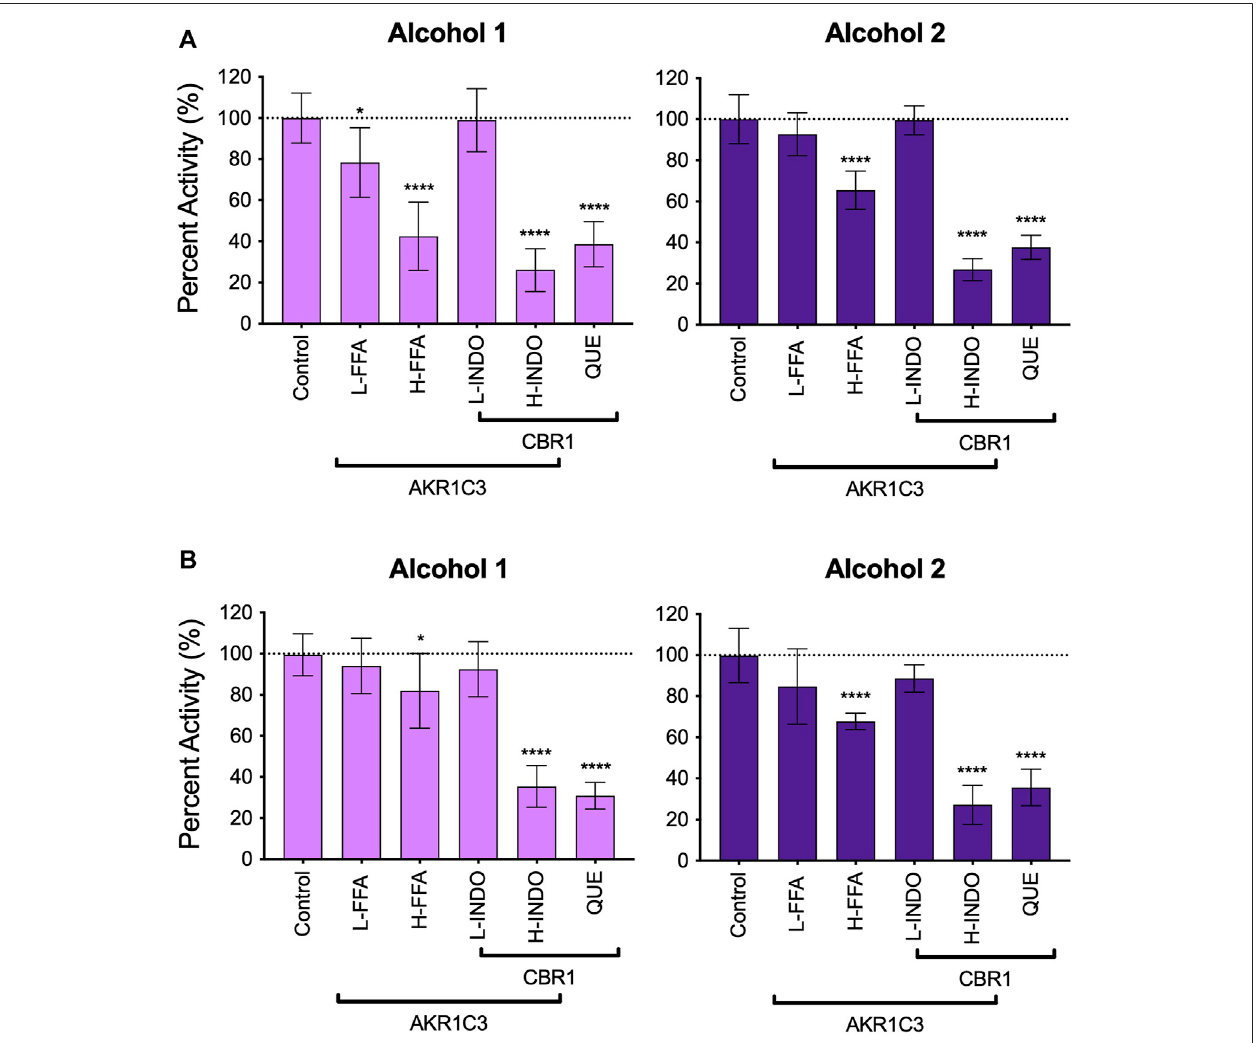
FIGURE 6 | Inhibitor phenotyping for 7- and 10-hydroxywarfarin carbonyl reduction reactions in human liver cytosol. Inhibitor reactions contained 1.0 mg/ml protein human liver cytosol in 50 mM potassium phosphate pH 7.4 and 5% methanol with 250 μ M substrate with and without reductase inhibitors for AKR1C3 and CBR1for (A) rac -7-hydroxywarfarinand (B) 10-hydroxywarfarin. Thespeci fi citiesoftheinhibitors areindicatedbythebars inwhich someinhibitors and conditions were speci fi cforeitherreductasewhileotherconditionsinhibitedbothreductases.Signi fi cancewasdeterminedusingonewayANOVAstatisticaltest.Abbreviationsare asfollows:L-FFA:low fl ufenamicacid(2 μ M);H-FFA:high fl ufenamicacid(10 μ M);L-INDO:lowindomethacin(5 μ M);H-INDO:highindomethacin(INDO,180 μ M);QUE: quercetin (60 μ